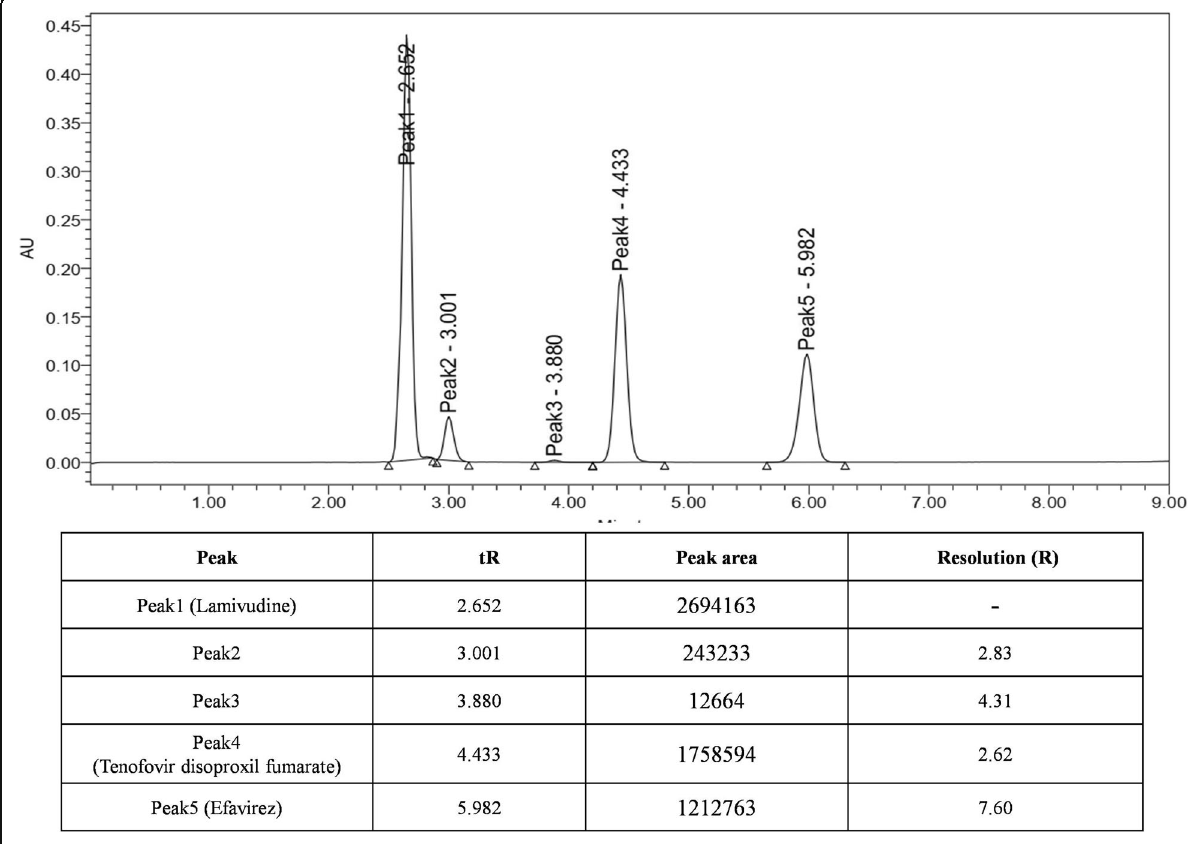
Fig. 7 Chromatogram of photo